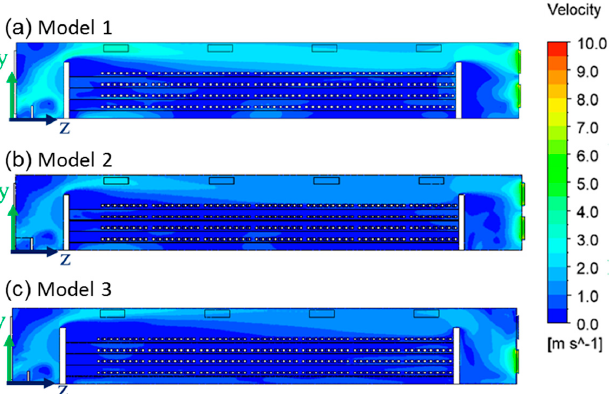
Figure 12. Velocity distribution of the three models’ yz plane of x = 2.6 m, at v = 6 m/s, ( a ) Model 1; ( b ) Model 2; ( c ) Model 3.